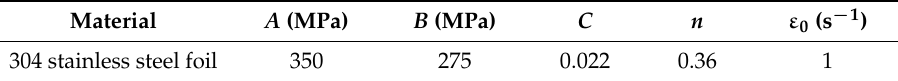
Table 4. Johnson-Cook model parameters of 304 stainless steel